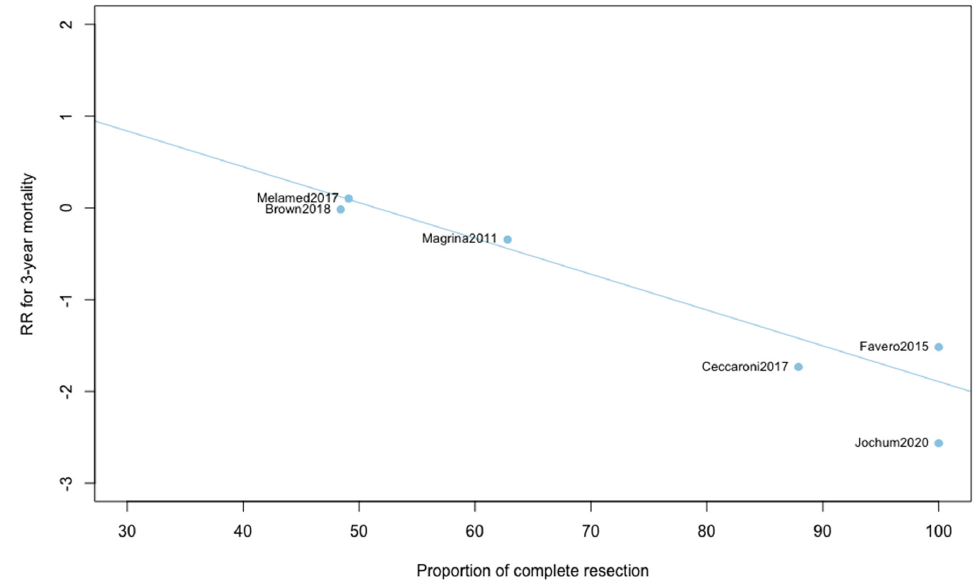
Figure 4. Metaregression of RR for 3-year mortality by proportion of complete resection. y = 2.01 − 0.04x.